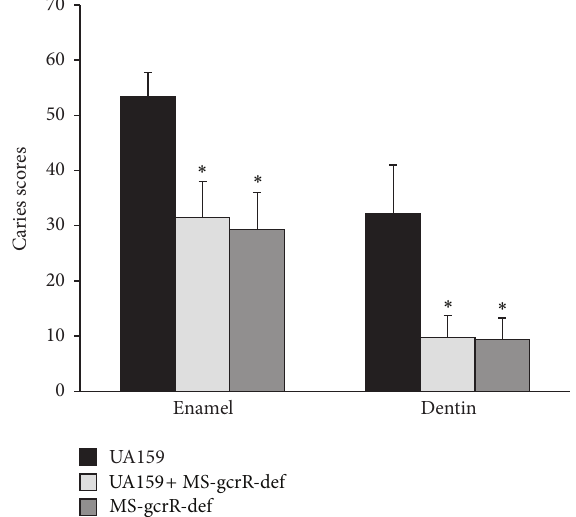
Figure 6: The enamel and dentinal caries scores of rats infected with UA159, MS-gcrR-def, and the mixture of both. The caries levels were scored by Keyes’ method. The results are expressed as mean ± S.D. values. Symbols for statistical significance: ∗ significantly different from the group UA159 infection alone ( 𝑃 < 0.05